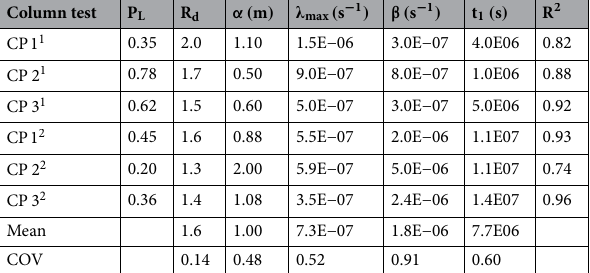
Table 6. Obtained fitting parameters. 1,2 Samples from first and second sampling